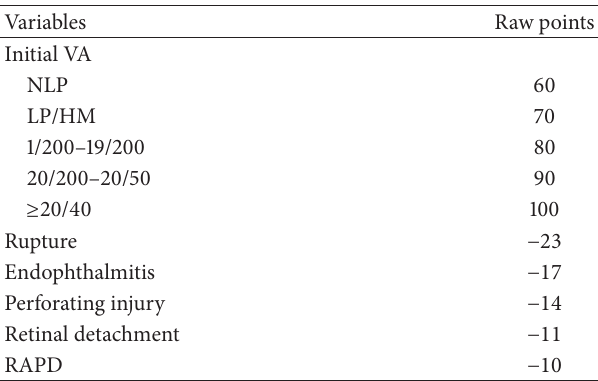
Table 1: Calculating the ocular trauma score (OTS): variables and raw points.